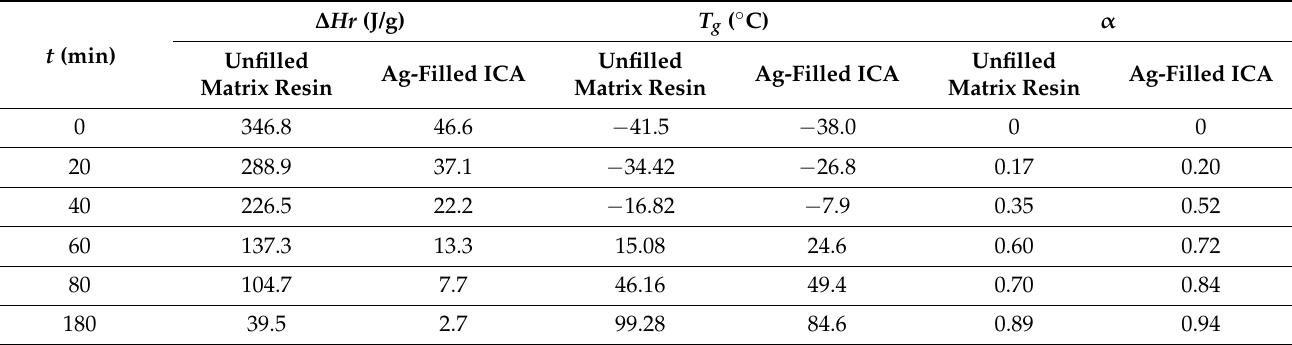
Figure 3. Post-curing curves of the unfilled matrix resin ( a ) and Ag-filled ICA ( b ) after being heated at 100 °C for different time periods. Table 4. Measured curing kinetics parameters of the Ag-filled ICA and its matrix resin.